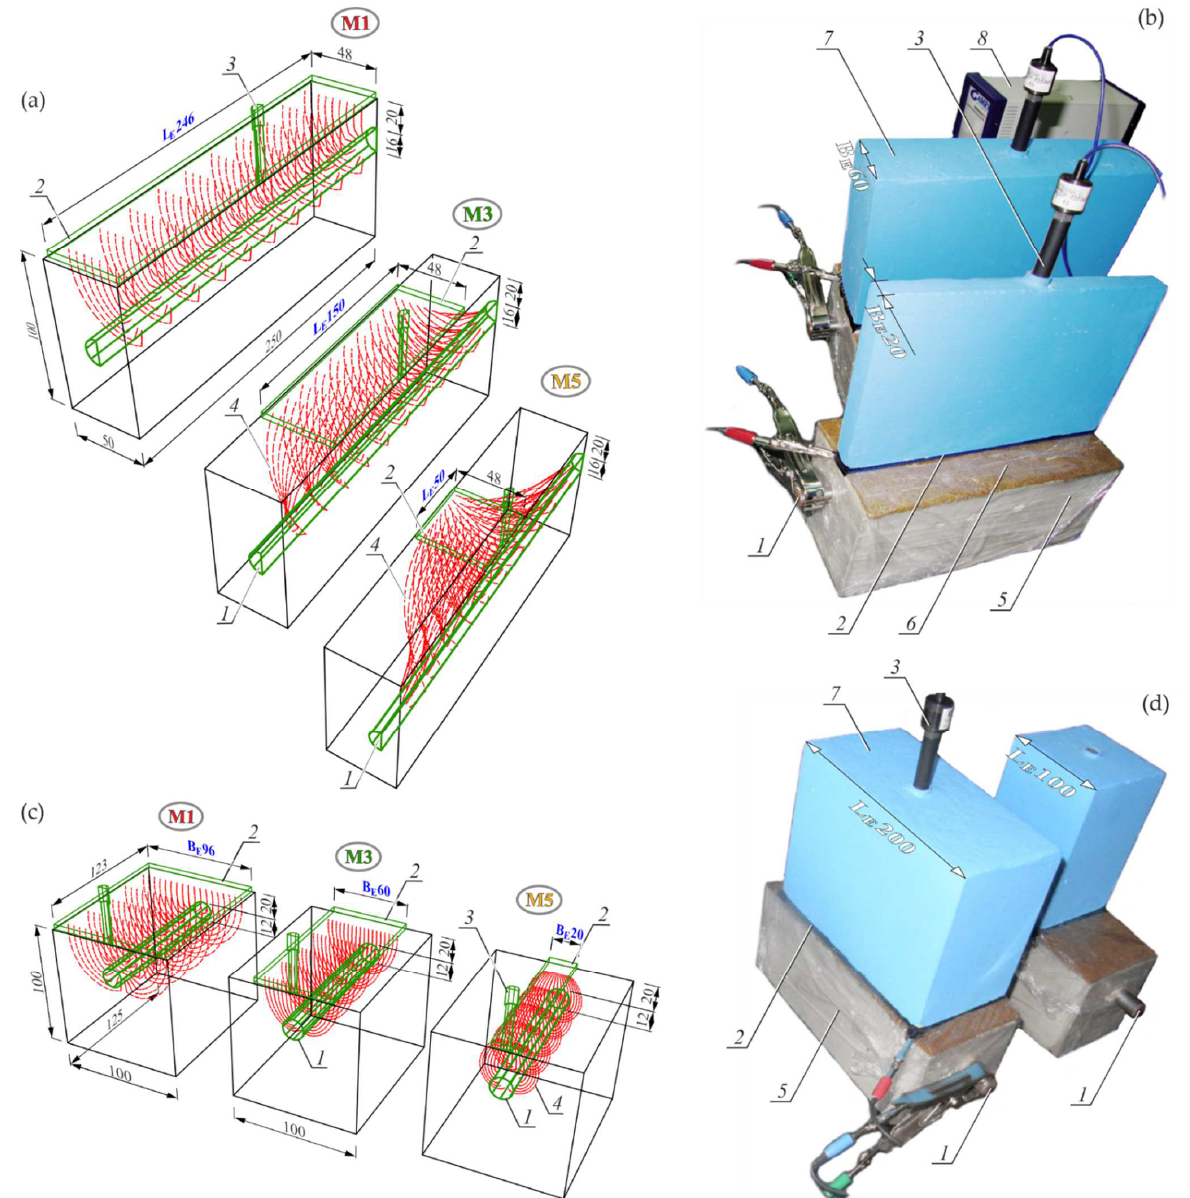
Figure 3. The three-electrode arrangements for testing the impact of the rectangular counter electrode geometry on shapes of impedance spectra of rebar in concrete: ( a ) 3D models of the system with a variable length L E of the counter electrode, ( b ) the test stand with counter electrodes of variable widths, ( c ) 3D models of the system with a variable width B E of the counter electrode, ( d ) the test stand with counter electrodes of variable lengths; 1—working electrode, 2—counter electrode, 3—reference electrode, 4—theoretical lines of current, 5—film, 6—felt, 7—ballast, 8—potentiostat. The impact of width was tested on two geometrically identical rectangular tests elements with dimensions of 250 × 100 × 100 mm, reinforced with single rebars with a